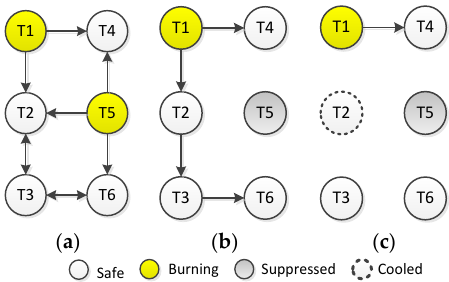
Figure 6. Optimal firefighting strategy for Scenario 3. ( a ) T1 and T5 are on fire. ( b ) T1 is on fire while T5 is suppressed d. ( c ) T1 is on fire, T5 has been suppressed, and T2 is cooled.